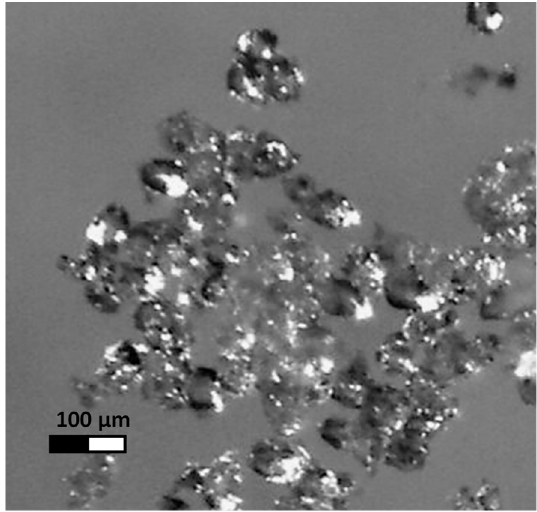
Figure 1. The optical microscopy visualization of the modified acetylated potato starch polymer (MSA).